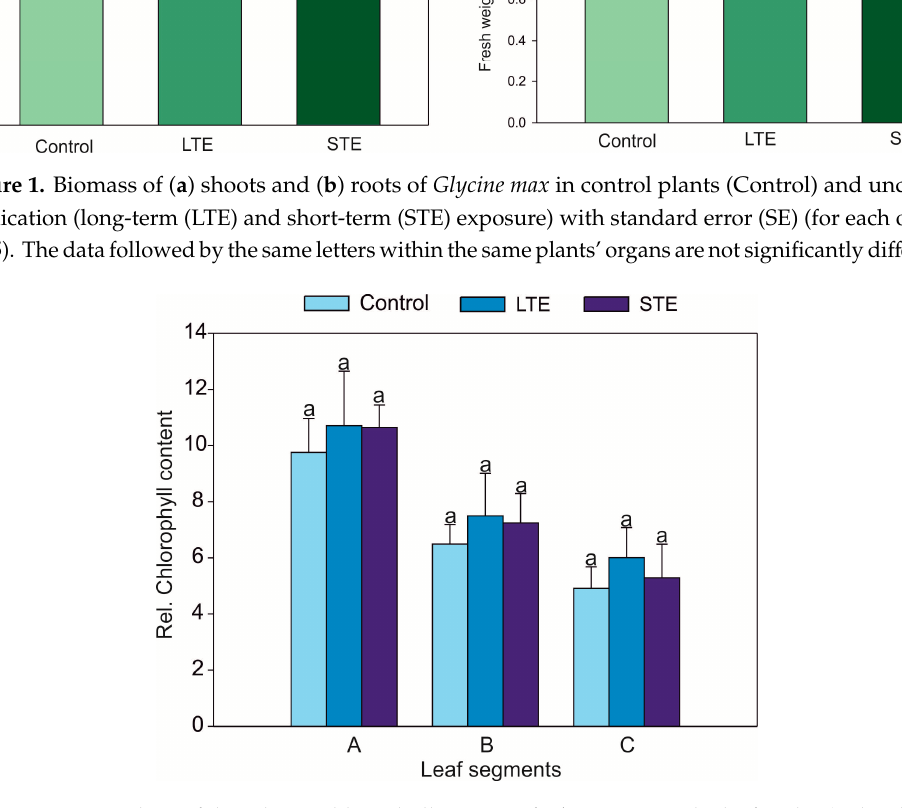
Figure 2. Mean values of the relative chlorophyll content of Glycine max in the leaf nodes (I: the closest; II: intermediate; and III: distant from the cotyledon) with standard error (SE). The data followed by the same letters within the same leaf nodes are not significantly different (for each node, n = 5). Abbreviations: LTE, long-term exposure to Sr; STE, short-term exposure to Sr .